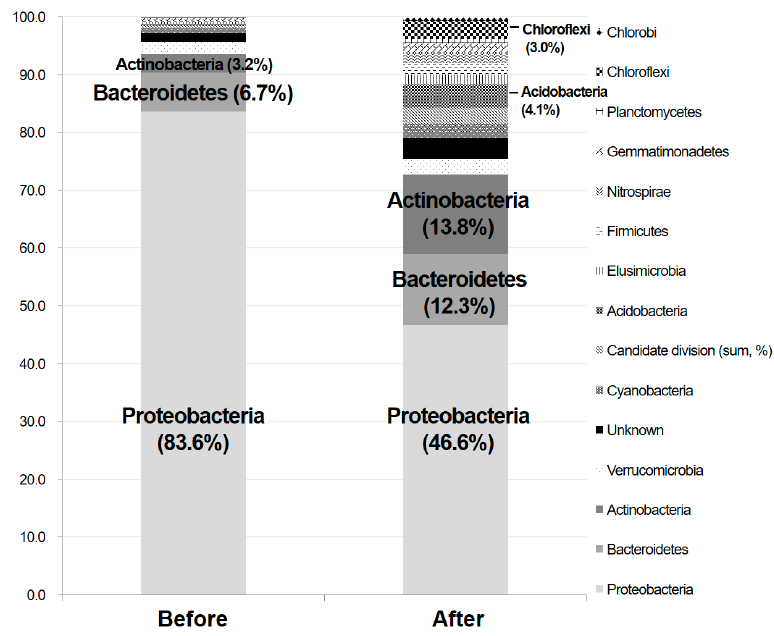
Figure 8. Comparison of phylum level distributions before and after air surging.